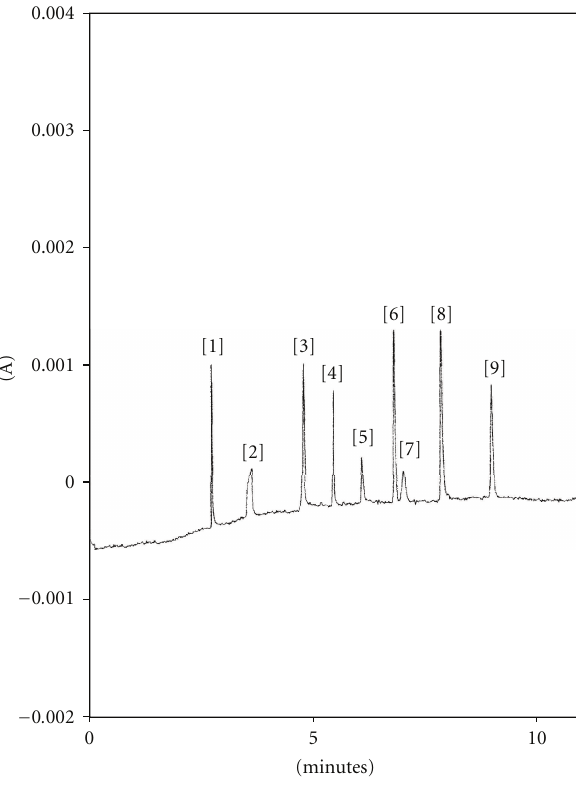
Figure 2: Electropherogram of standard mixture in basic BGE.